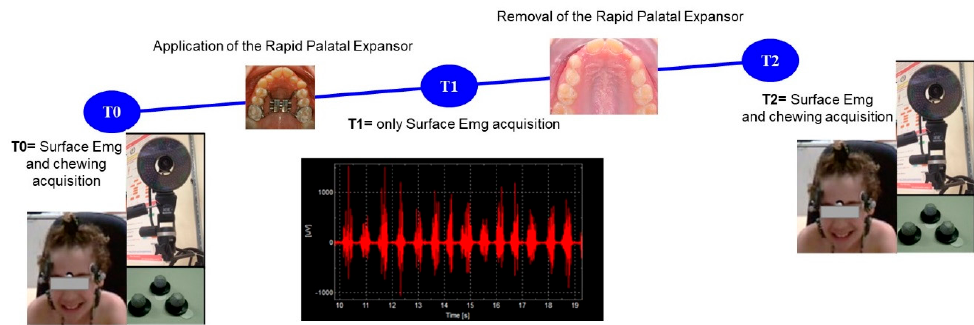
Figure 1. Timeline of the project.